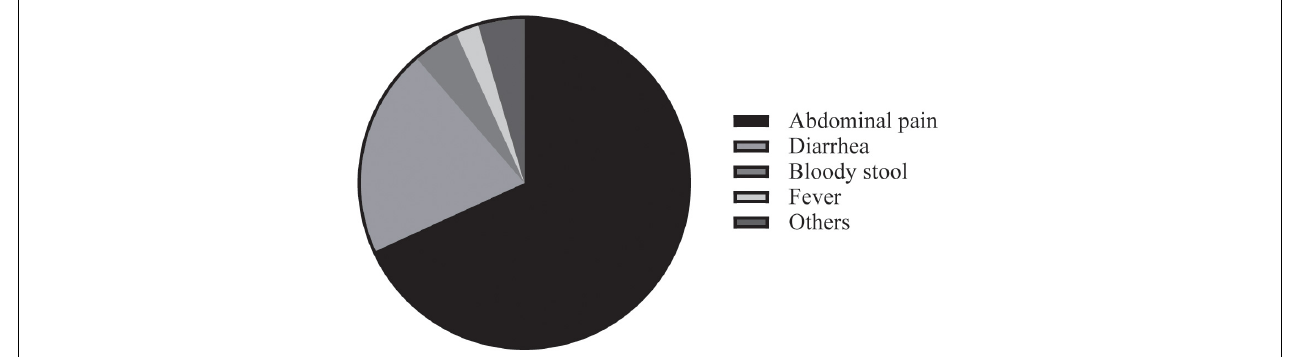
FIGURE 1 | Worsening symptoms during the COVID-19 pandemic.